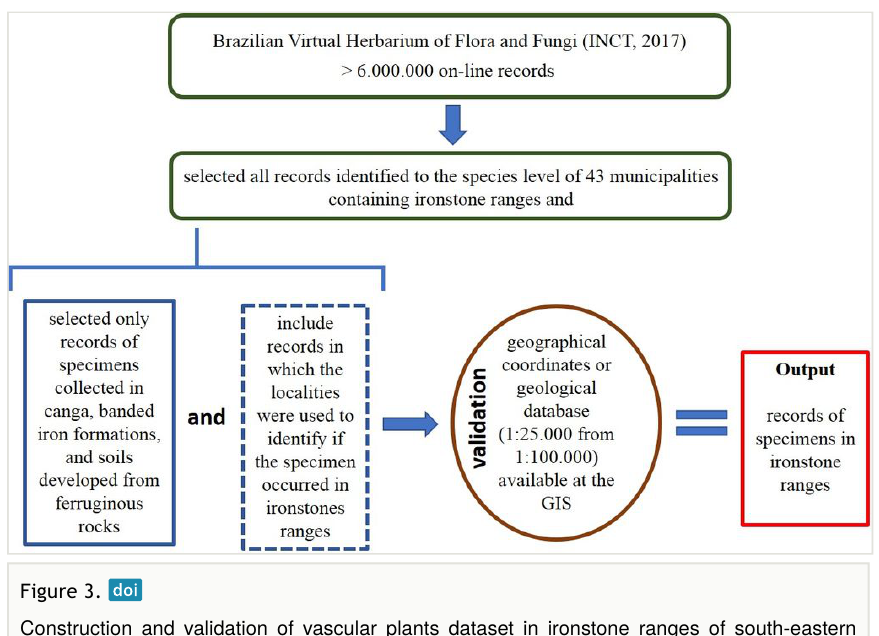
Construction and validation of vascular plants dataset in ironstone ranges of south-eastern